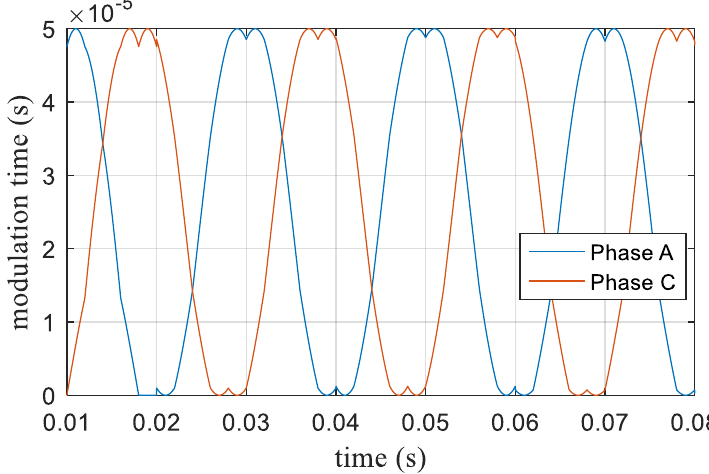
Energies 2019 , 12 , x FOR PEER REVIEW Figure 19. Modulation time curve of the space vector voltage based on the new algorithm at m = 1.1.